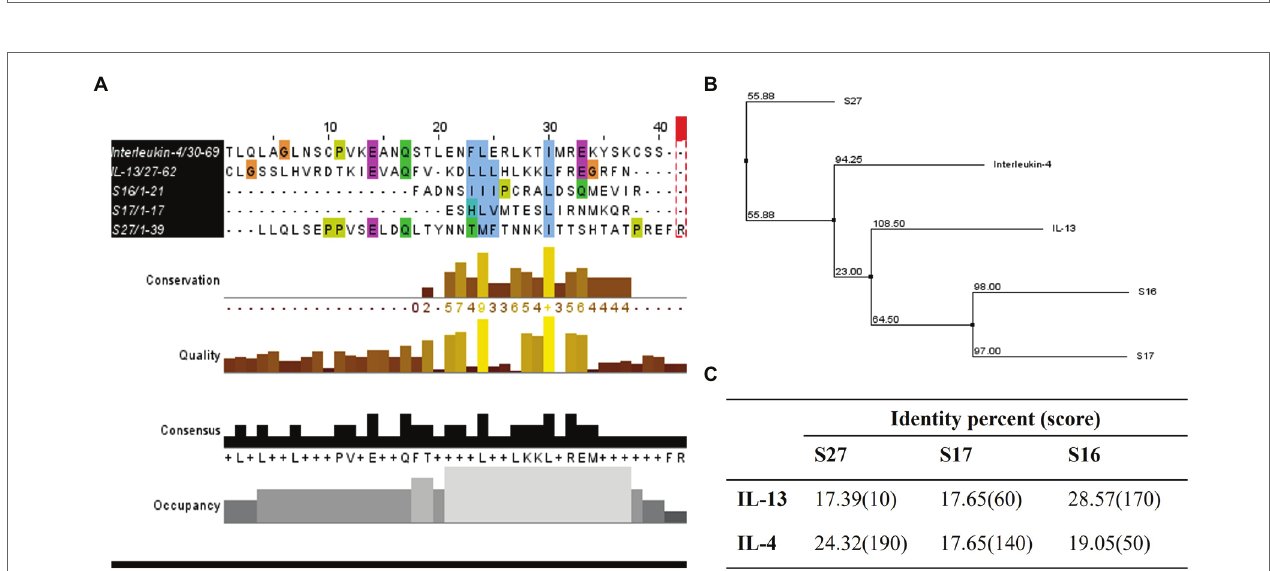
FIGURE 7 | Homology studies between S16, S17, S27, and IL-13 and IL-4. (A) Sequence alignment of tested proteins using ClustalOmega and MuscleWS. The colors represent the level of conservation between protein sequences. The blue colored residues are conserved between all proteins (high conservation), while the green and pink are more conserved between S27 and IL-4/IL-13, and the yellow residues are more conserved between S27 and IL-4 (low conservation). Consensus sequence is the most frequent amino acid residues in the alignment, while the occupancy represents the level of the primary consensus binding site motif. (B) Neighbor-joining tree using BLOSUM62. (C) Pairwise alignment to calculate the identity percentage. Jalview 2.11.1.4 software was used for visualization.